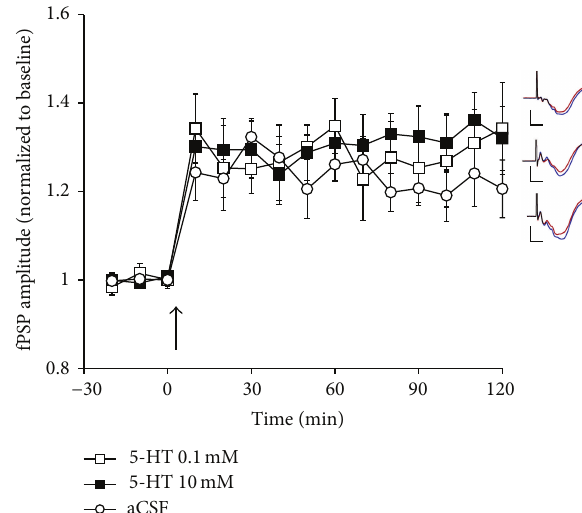
Figure 3: The effect of application (in V1 by means of reverse microdialysis) of either aCSF ( 𝑛 = 8 ) or 5-HT (0.1 or 10mM; 𝑛 = 5 and 7, resp.) on LTP following TBS (at arrow) of the LGN in urethane-anesthetized rats. Application of 5-HT did not result in any significant changes in LTP relative to rats receiving aCSF. Inserts depict typical fPSPs before (red) and after (blue) LTP induction for animals in the presence of 0.1 mM 5-HT (top), 10mM 5-HT (middle), or aCSF (bottom; calibration bars indicate 0.5 mV vertical and 10 ms horizontal; each fPSP trace is an average of 30 min of continuous